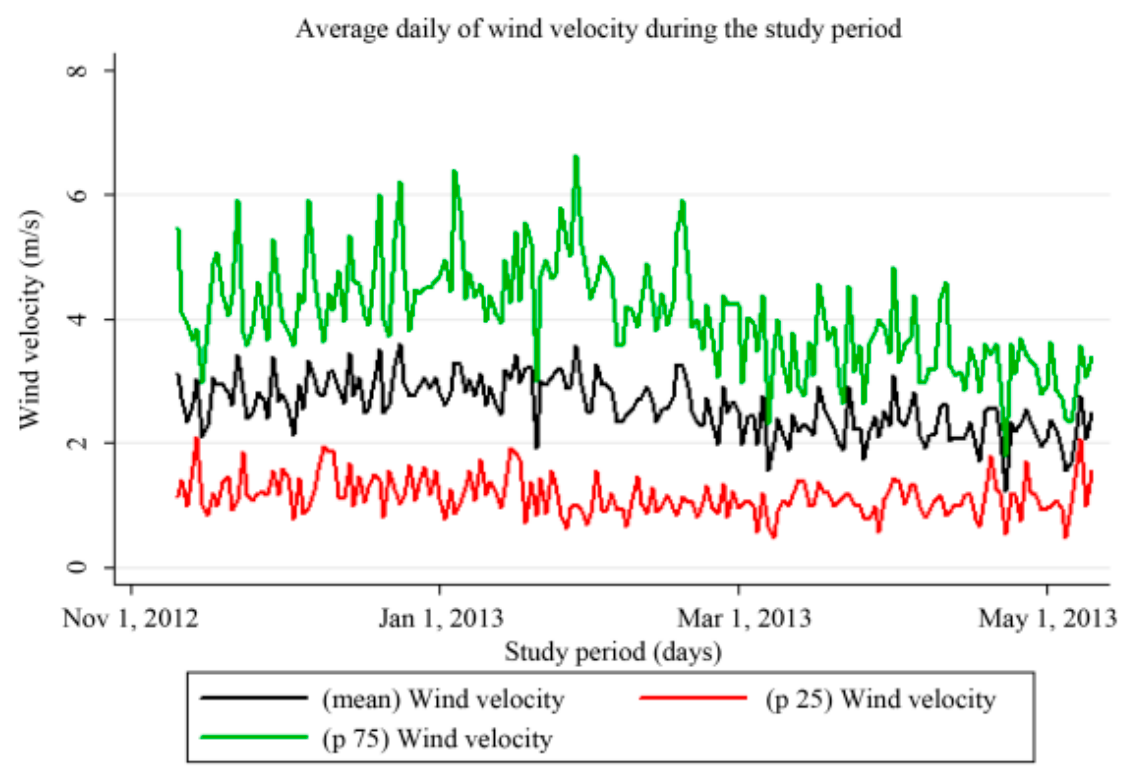
Figure 10. Monitoring Study PM 2.5 Tailings Deposit Chañaral Chile [55].